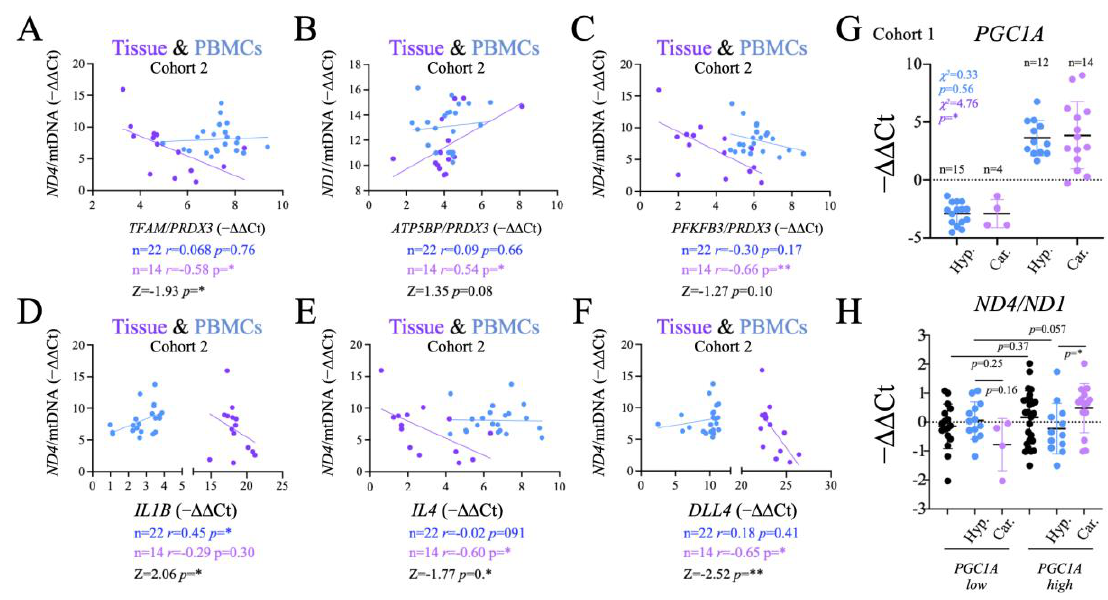
Figure 7. Correlation and linear regression analysis of ND1 /mtDNA and ND4 /mtDNA ratios from tissue and PBMC samples with metabolic, inflammation and angiogenesis gene expression data from PBMCs. ( A ) Correlation and linear regression analysis of ND4 /mtDNA vs. TFAM/PRDX3 in thyroid tissue and PBMC samples. ( B ) Correlation and linear regression analysis of ND1 /mtDNA vs. ATP5BP/PRDX3 in thyroid tissue and PBMC samples. ( C ) Correlation and linear regression anal- ysis of ND4 /mtDNA vs. PFKFB3/PRX3 in thyroid tissue and PBMC samples. ( D ) Correlation analy- sis of ND4 /mtDNA vs. IL1B in thyroid tissue and PBMC samples. ( E ) Correlation and linear regres- sion analysis of ND4 /mtDNA vs. IL4 in thyroid tissue and PBMC samples. ( F ) Correlation and linear regression analysis of ND4 /mtDNA vs. DLL4 in thyroid tissue and PBMC samples. ( G ) Frequency analysis of PGC1A -high vs. PGC1A -low patients. ( H ) ND4/ND1 ratio in PGC1A -high vs. PGC1A -low patients. Data are mean ± standard deviation (SD). *, p < 0.05; **, p ≤ 0.01.